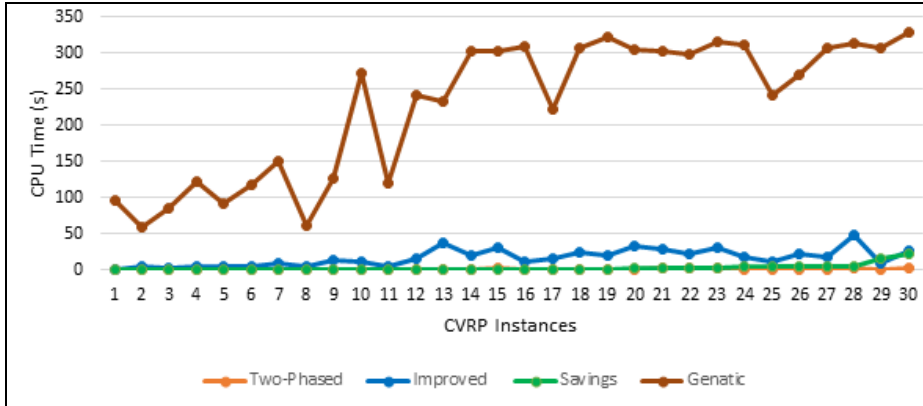
Figure 3 : Consumed CPU time for execution. Table 3: Results of the four heuristic algorithms.